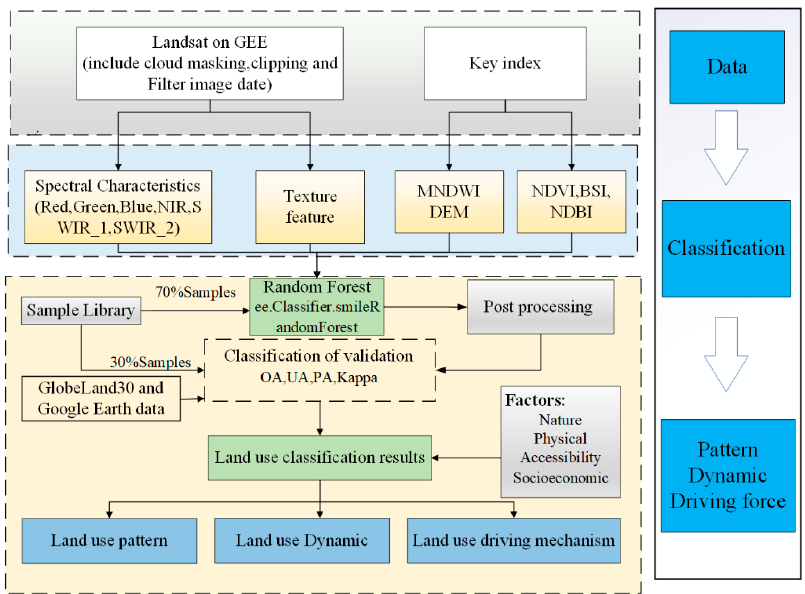
Figure 4. Methodological flowchart for this study.